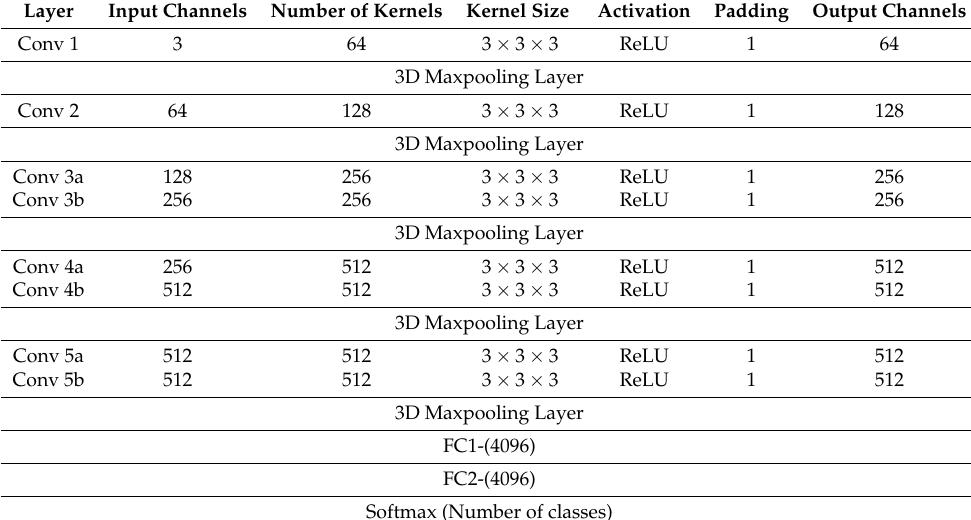
Figure 2. The visual overview of 3D kernel operation. ( a ) Combined 3D Convolution kernel operation on stack of frames, ( b ) ( 2 D + 1 D ) kernels separate operations on input frames for spatio-temporal features extraction. Table 1. Architectural details of the proposed 3DCNN teacher